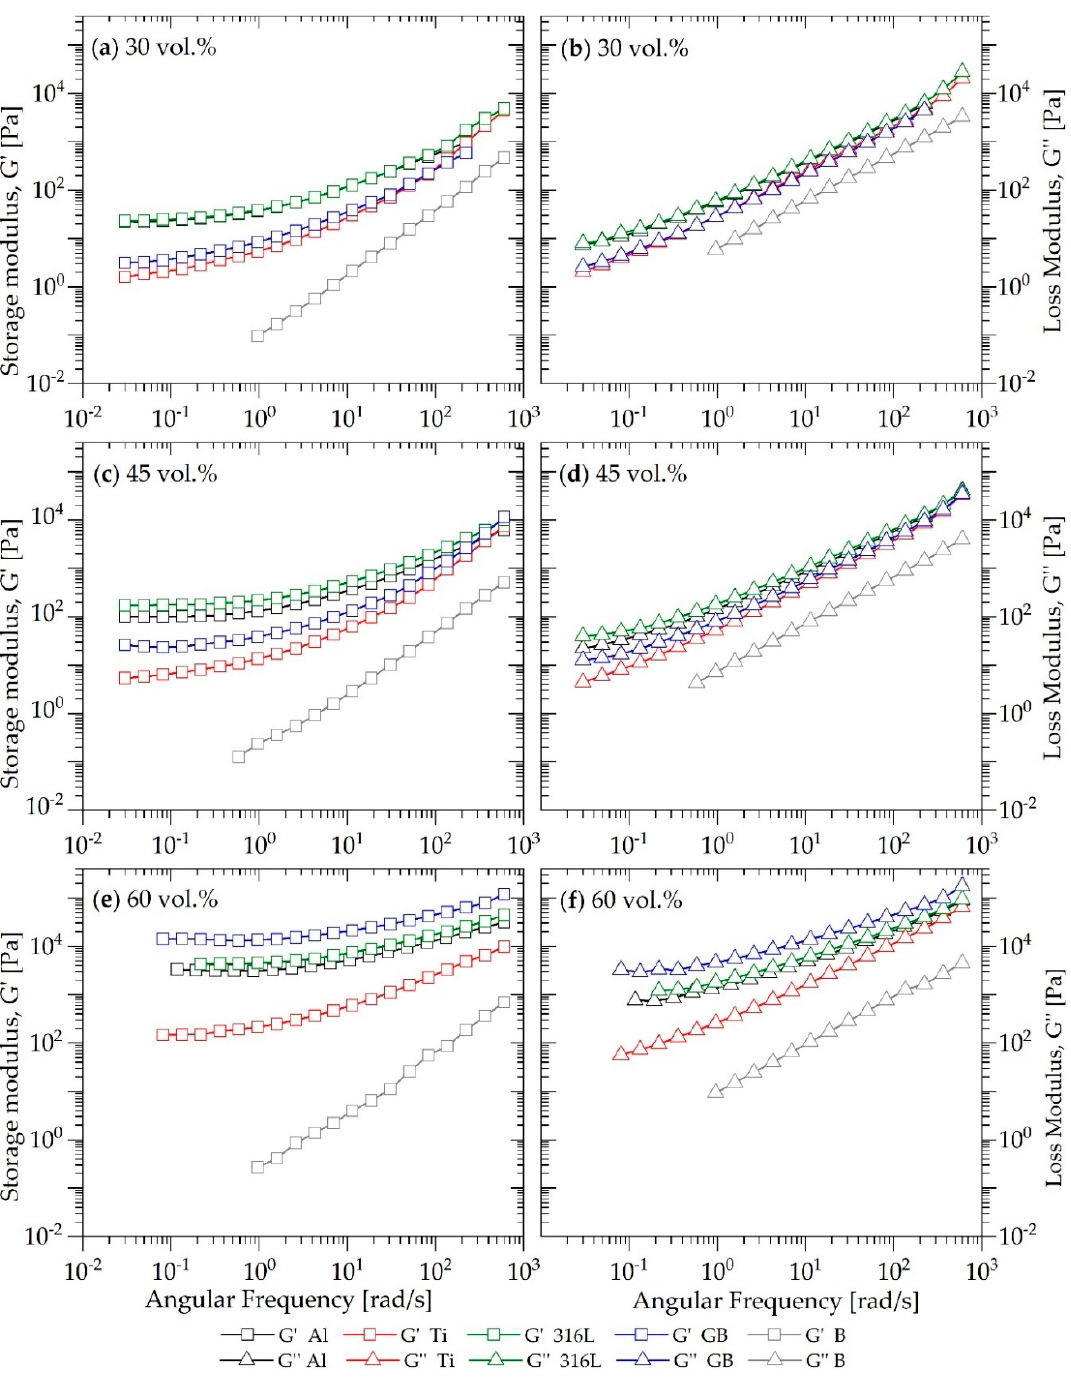
Figure 6. The influence of filler material on storage G ′ and loss G ″ modulus in the frequency domain for all filler loadings: ( a ) G ′ for 30 vol.%, ( b ) G ″ for 30 vol.%, ( c ) G ′ for 45 vol.%, ( d ) G ″ for 30 vol.%, ( e ) G ′ for 60 vol.%, and ( f ) G ″ for 60 vol.%.